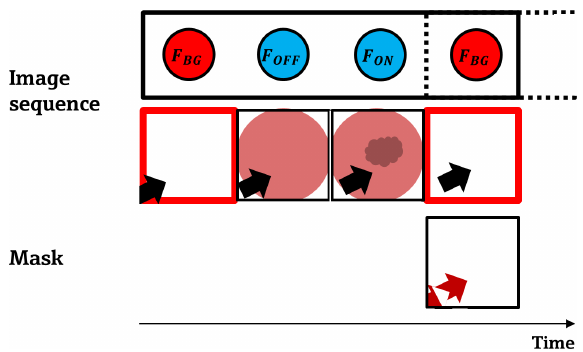
Figure 4. Sketch of the two-image frame difference that is applied to subsequent background images ( F BG ). A mask is gained that is used to get rid of incorrect CL information due to moving objects or reflections. The black arrow represents an object moving through the camera’s field of